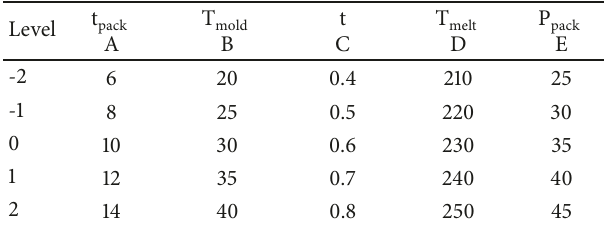
Table 6: Experimental factors and their